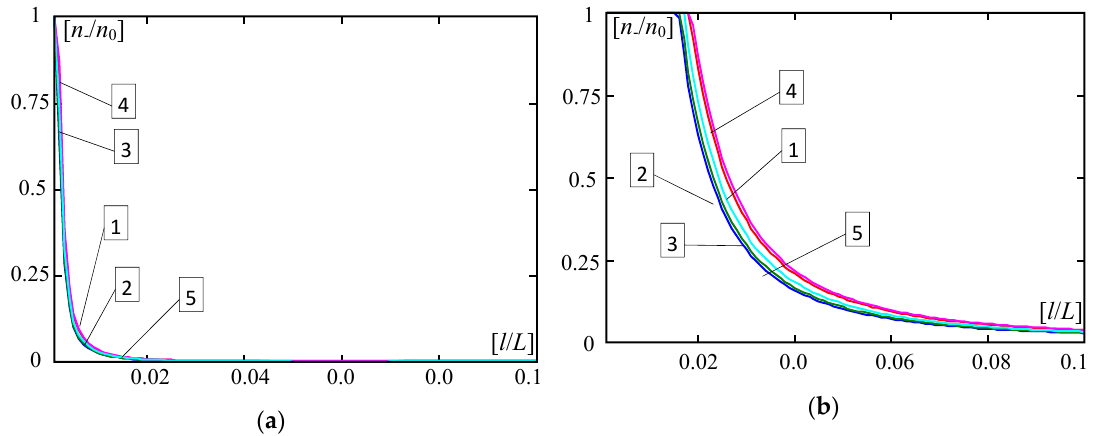
Figure 7. Values of ratios n _ / n 0 versus l / L ( E ” / E ’ = 0.5, d / L = 0.001, m = 1). ( a ) For κ = 0.0001; ( b ) For κ =